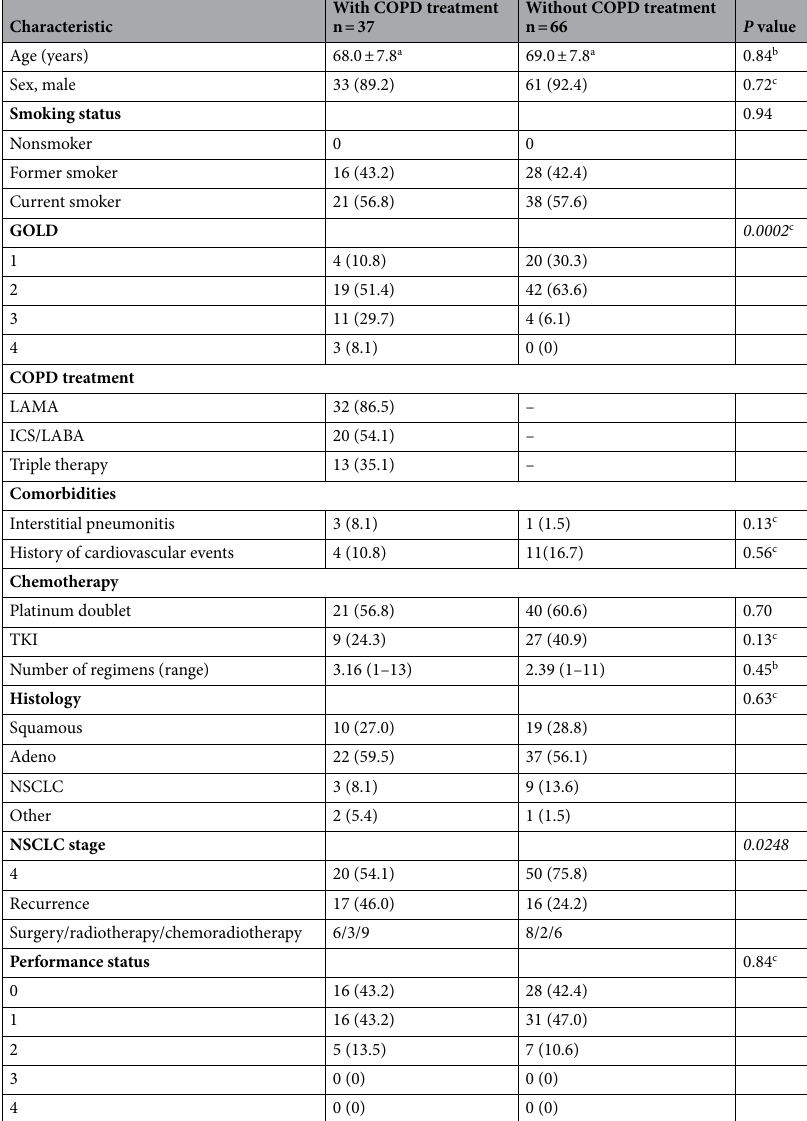
Table 3. Clinical characteristics in COPD group. Continuous variables are presented as the mean, and categorical variables are presented as the number (%). Comparisons were made by means of chi-squared tests unless otherwise indicated. Significant values are in [italics]. GOLD The Global Initiative for Chronic Obstructive Lung Disease, LAMA Long-acting muscarinic antagonist, ICS Inhaled corticosteroid, LABA Long- acting beta agonist, TKI Tyrosine kinase inhibitors, NSCLC Non-small-cell lung cancer. a Mean ± SD. b Wilcoxon signed-rank test. c Fisher’s exact